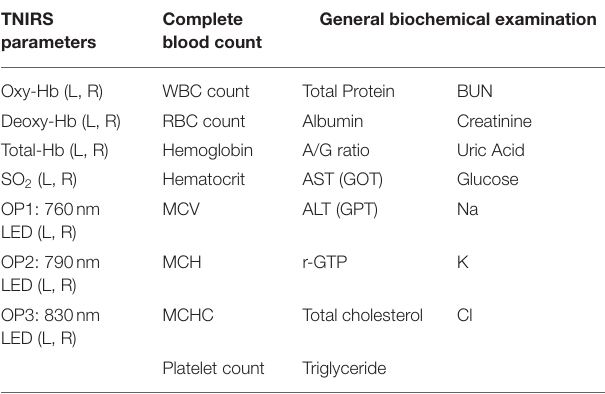
TABLE 1 | TNIRS parameters and blood test data. TNIRS parameters